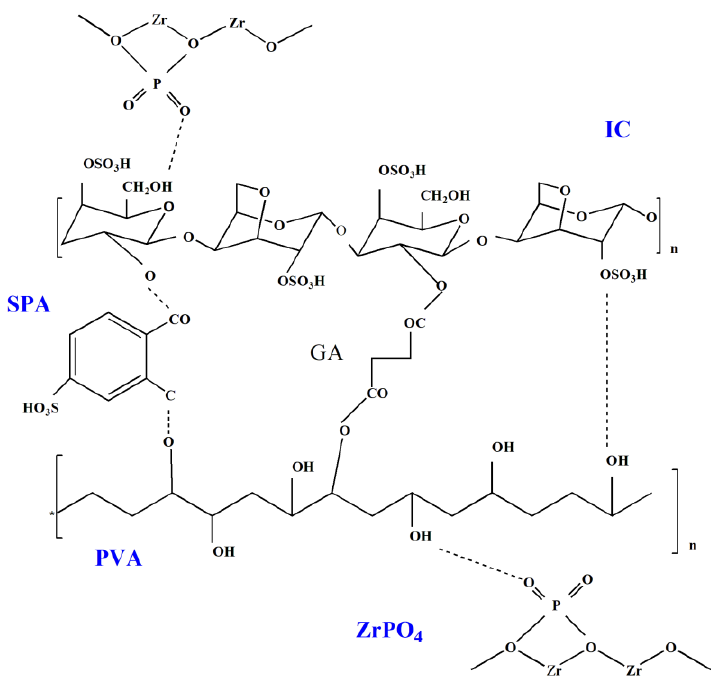
Figure 1. Possible interaction of the IC/SPVA/ZrPO 4 membrane.